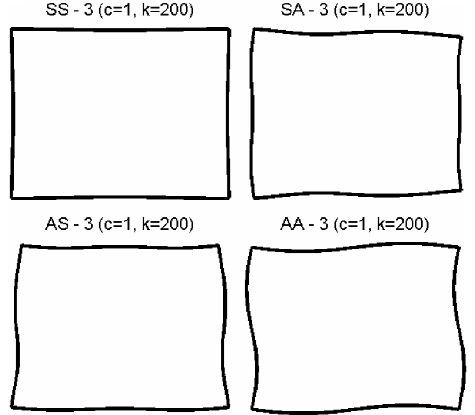
Fig. 4. Mode shapes (3 rd mode, Case 1, c =